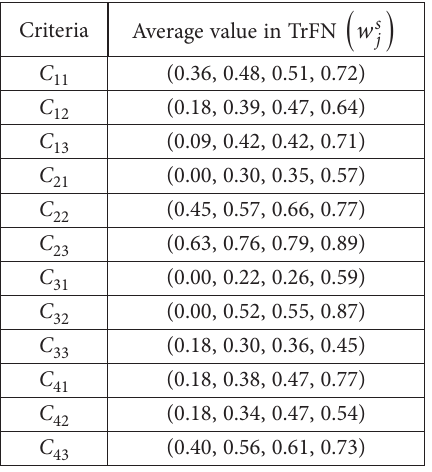
Table 8. Calculated entropy measure, divergence and objective weight for each criterion